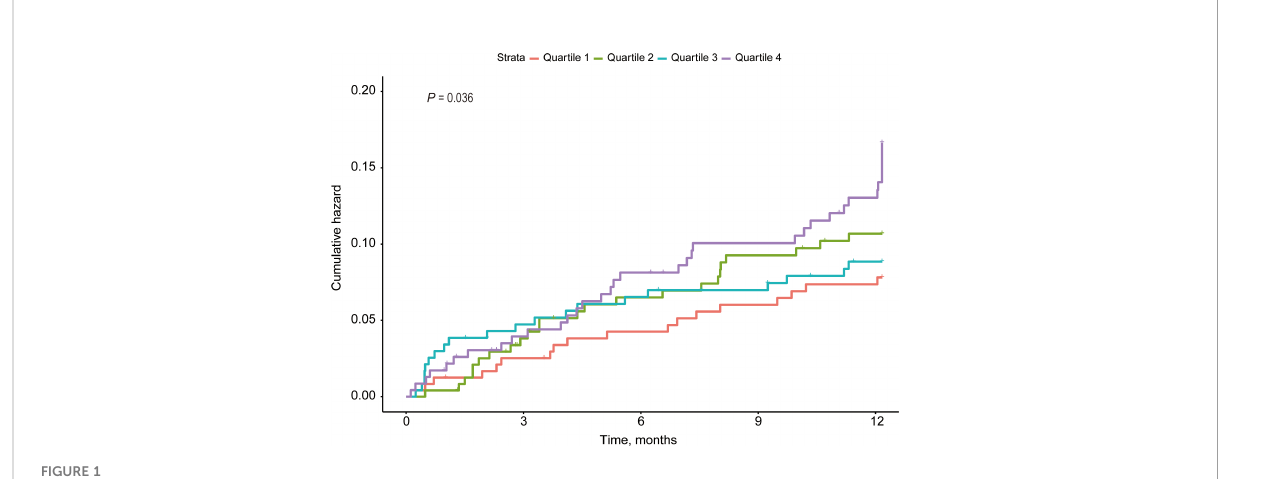
FIGURE 1 Cumulative Hazard Curves of Stroke Recurrence by TyG index.